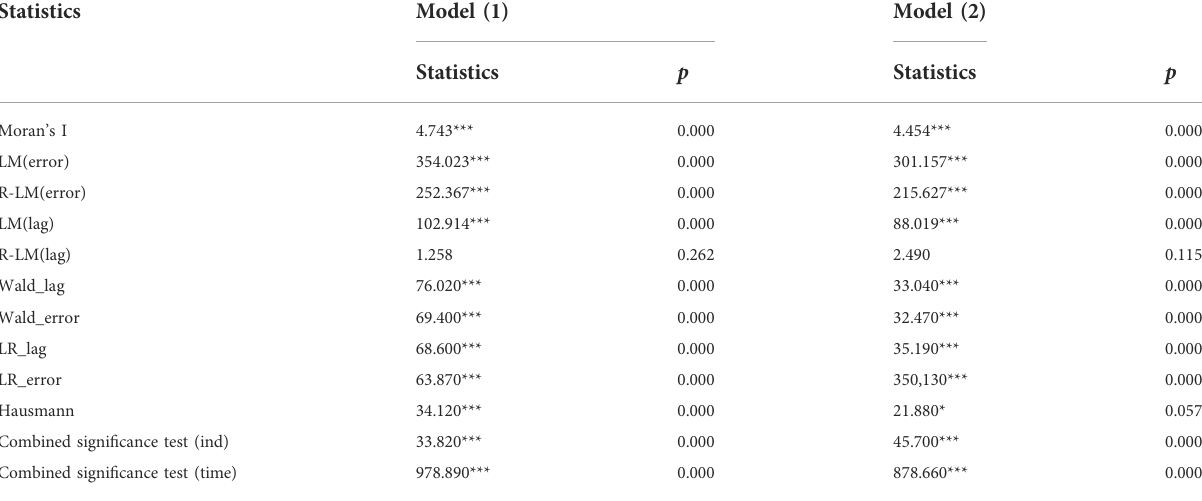
TABLE 6 Test results of spatial econometric model.